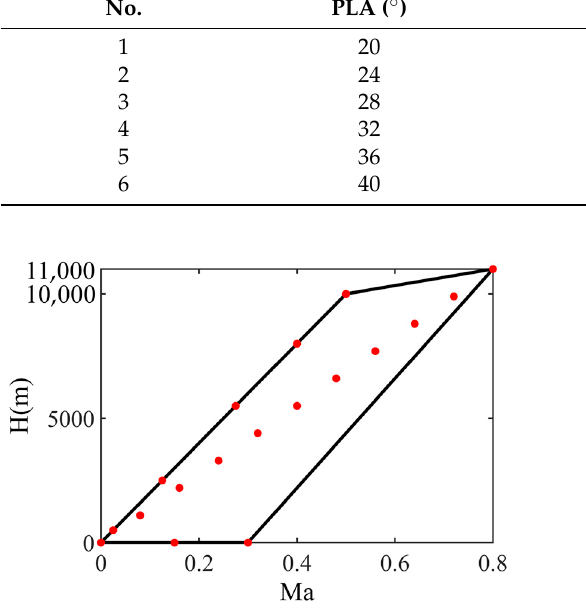
Figure 6. Model input v : Selection of the flight condition. Table 5. Model input u : Command of the PLA.